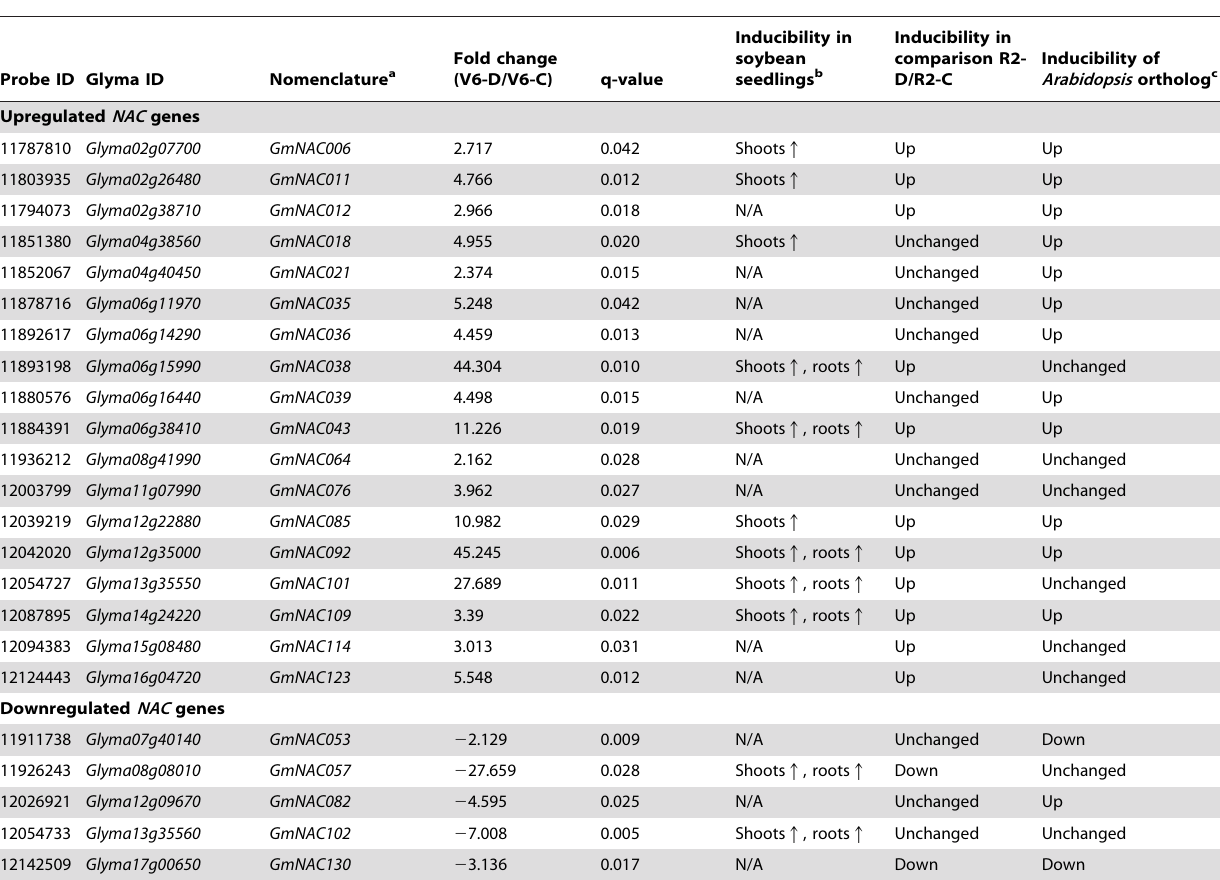
Table 2. Differential expression of GmNAC genes in different tissues under drought stress.